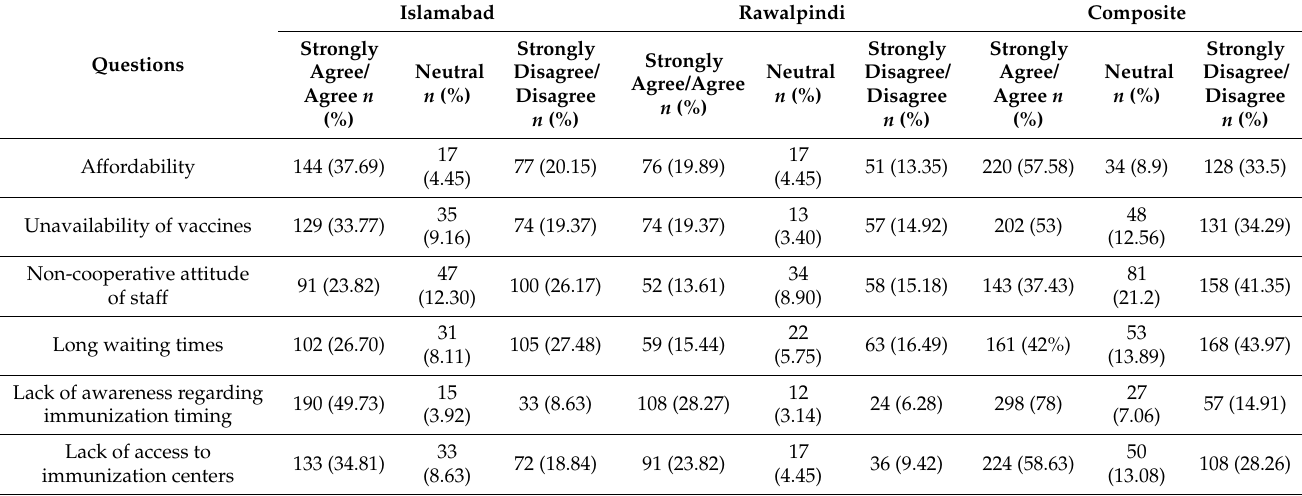
Table 4. Perceptions of parents regarding factors responsible for delay in immunization of their